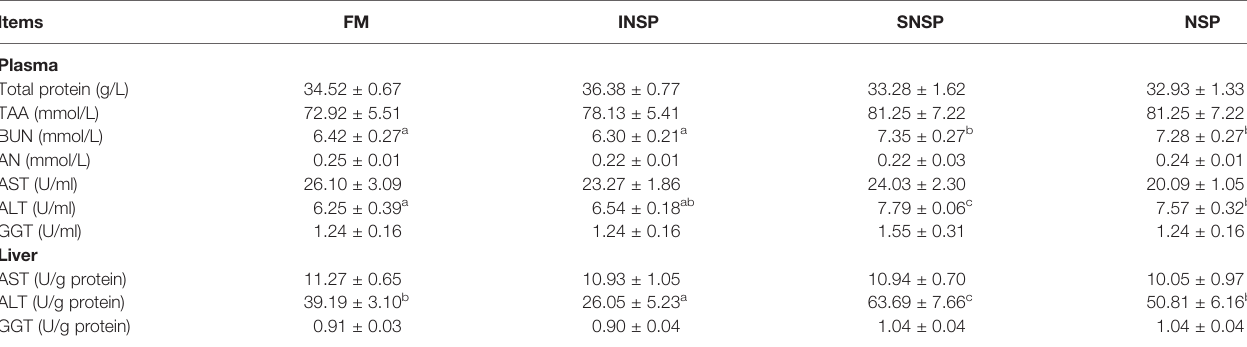
Values aremeans ± SEM(n= 3). Means in thesame rowwith differentsuperscripts aresigni fi cantly different fromeach other (P < 0.05). TAA,total amino acids;BUN, blood urea nitrogen; AN, ammonia nitrogen; AST, aspartate aminotransferase; ALT, alanine aminotransferase; GGT, g -glutamyl